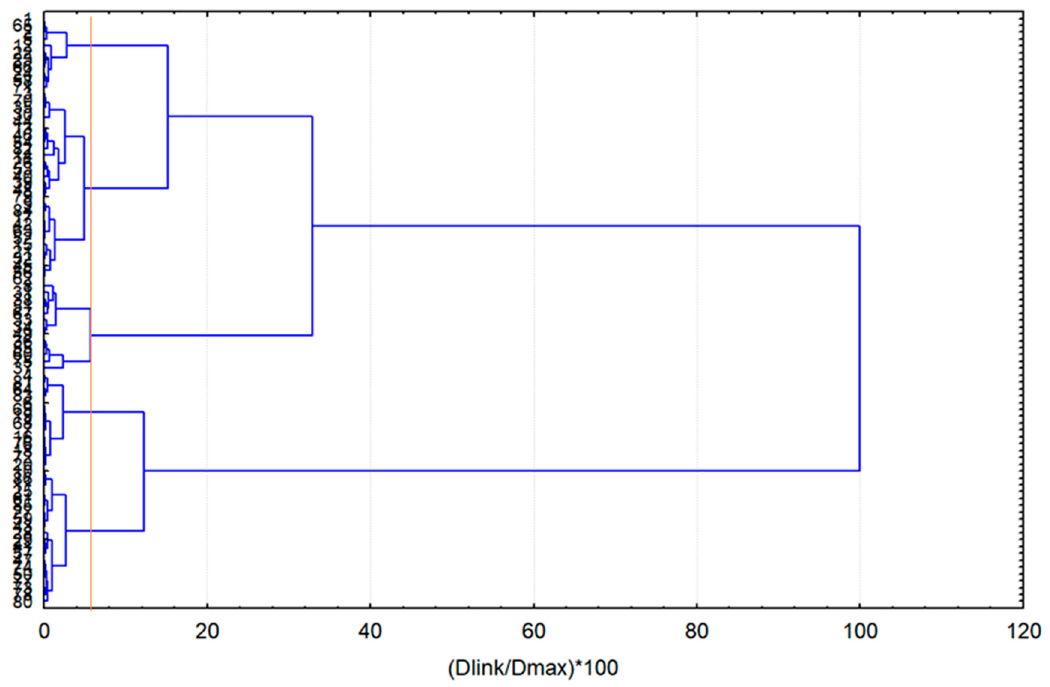
Figure A1. Tree diagram (dendrogram) for 86 cases Ward’s methods Euclidean distances.